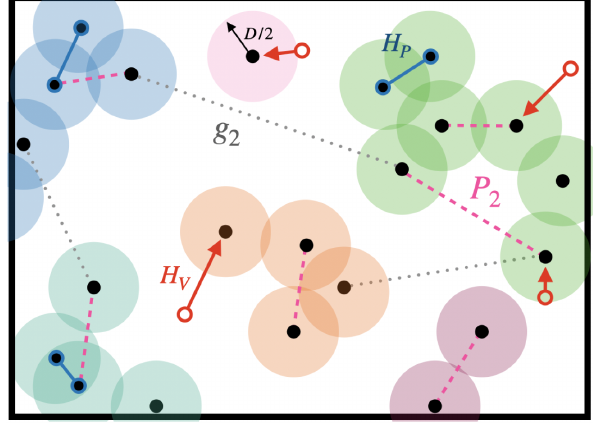
FIG. 1. Schematic depicting the various statistical descriptors used in this work. The black points indicate the positions of random particles (here visualized in R 2 ), with the groups of colored circles (each of diameter D ) demonstrating the clusters. The pair correlation function g 2 counts pairs of particles belong- ing both to the same cluster (pink lines) and to different clusters (gray lines), whereas the pair-connectedness function P 2 contains only particles within the same cluster (pink lines). We show also the nearest-neighbor functions: H encodes the distance between V a randomly positioned point and the nearest galaxy (red arrows), while H gives the separation between a galaxy and its closest P neighbor (blue lines). Further details on these statistics are given in Sec.